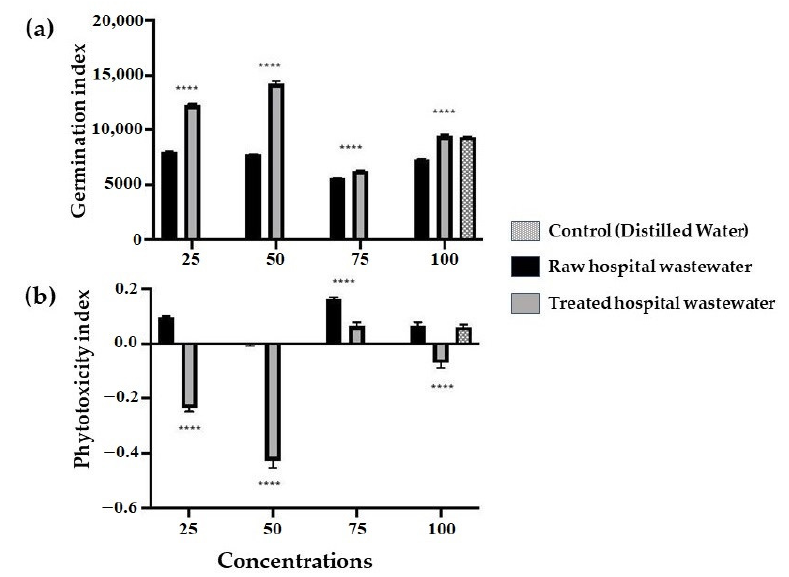
Figure 5. ( a ) Germination indices of Radish seeds grown in untreated and treated hospital wastewaters; ( b ) Phytotoxicity indices of Radish seeds grown in untreated and treated hospital wastewaters. Significance (Welch’s test) between treated and untreated hospital wastewater is indicated by p < 0.0001 ****.